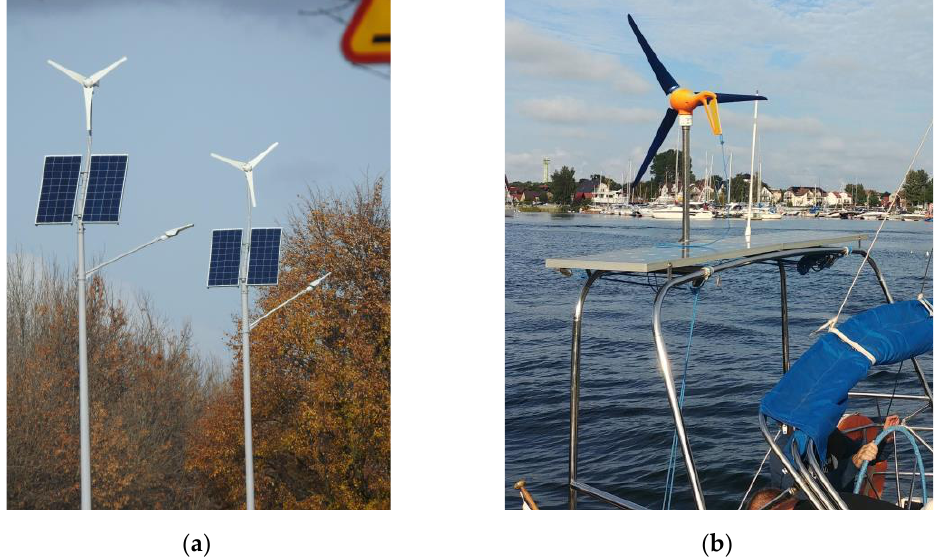
Figure 1. Hybrid power supply from renewable energy sources: ( a ) street-lighting lamp; ( b ) on the yacht.